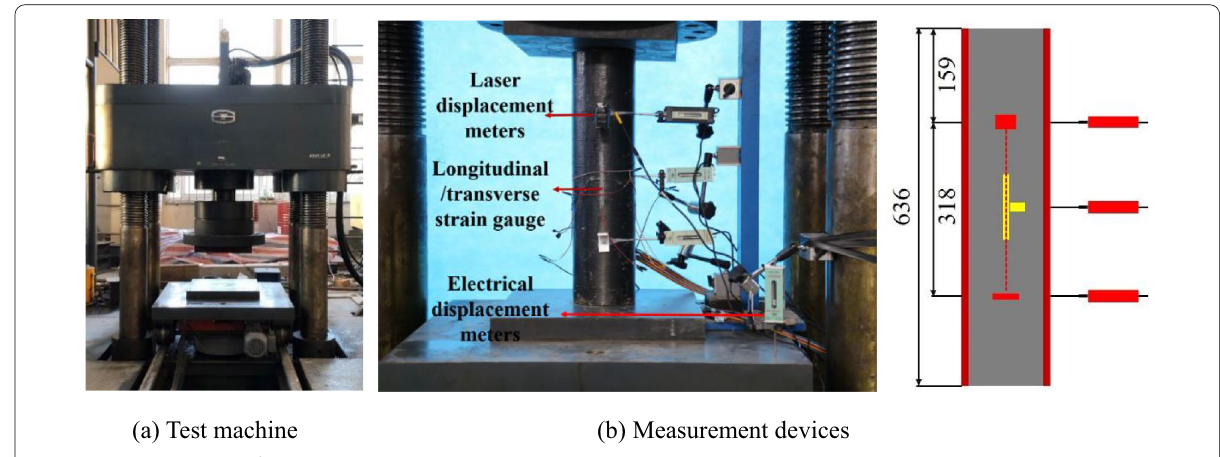
Fig. 7 Test arrangement and instruments (Unit: mm)